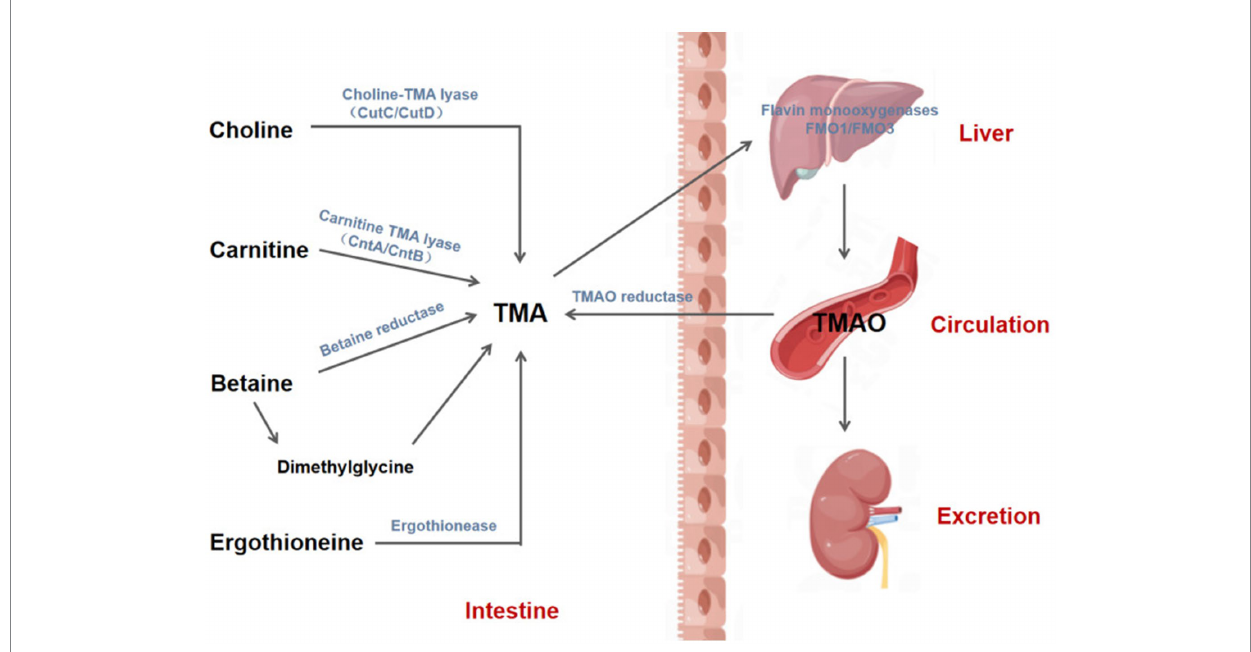
FIGURE 1 Biosynthesis and metabolism of TMAO. TMA is produced by gut mictrobiota through the action of various enzymes to metabolize phosphatidylcholine/choline, carnitine, betaine and ergothionein in the diet, and then absorbed by the intestine and transported to the liver through the portal vein, where TMA is further oxidized to TMAO by flavin monooxygenases 1 and 3 (FMO1/3). Afterwards, TMAO enters the circulatory system and is eventually excreted in the urine or reduced to TMA by TMAO reductase in the intestine. CutC/CutD, Choline trimethylamine-lyase system; CntA, A Rieske-type oxygenase protein; CntB, a predicted reductase with a plant-type ferridoxin domain; TMA, Trimethylamine; TMAO, Trimethylamine-N-